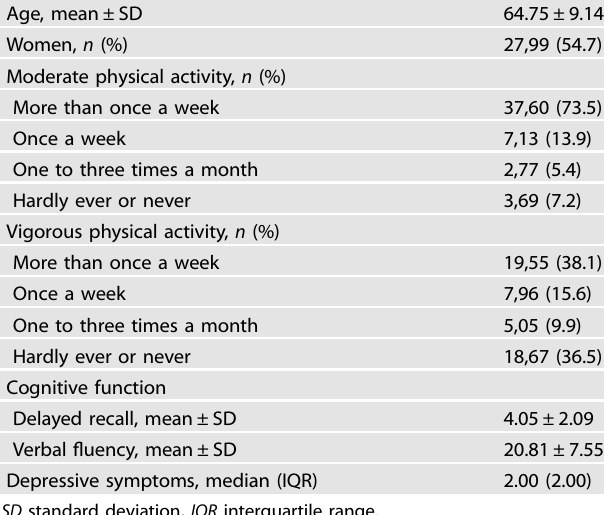
Table 1. Baseline characteristics of participants ( n =